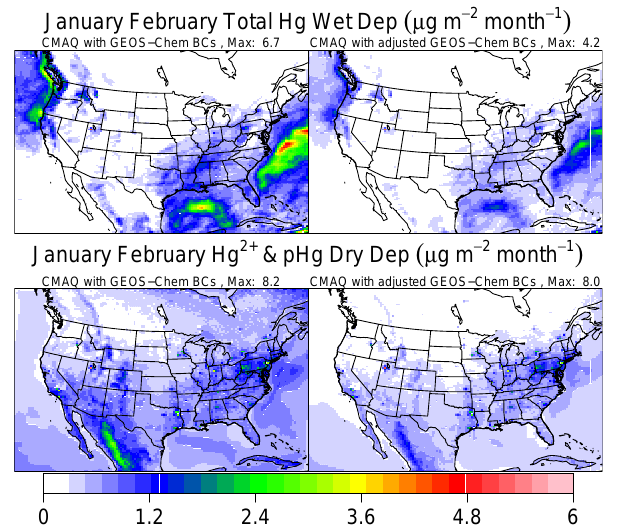
CMAQ with GEOS−Chem BCs , Max: 12.4